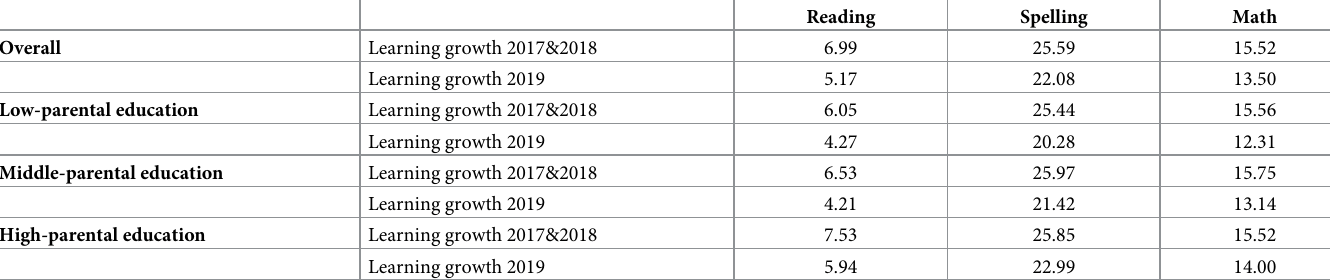
Table 4. Descriptive statistics unstandardized learning gains per